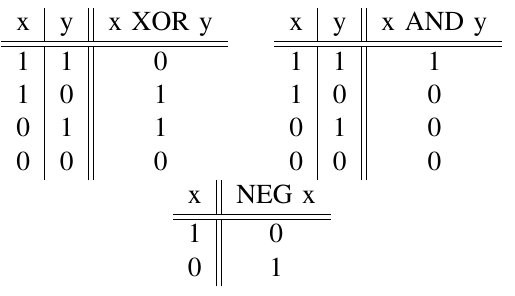
Fig. 2. Multiplication and addition in F